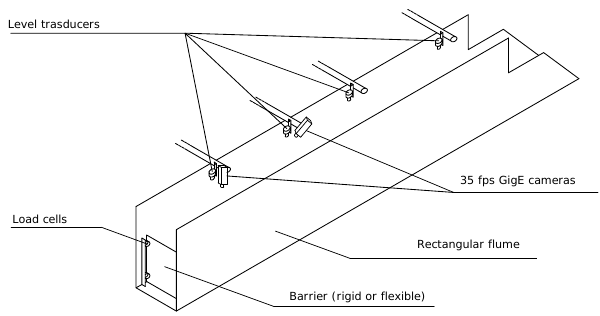
Fig. 2. Functional scheme of the flume.